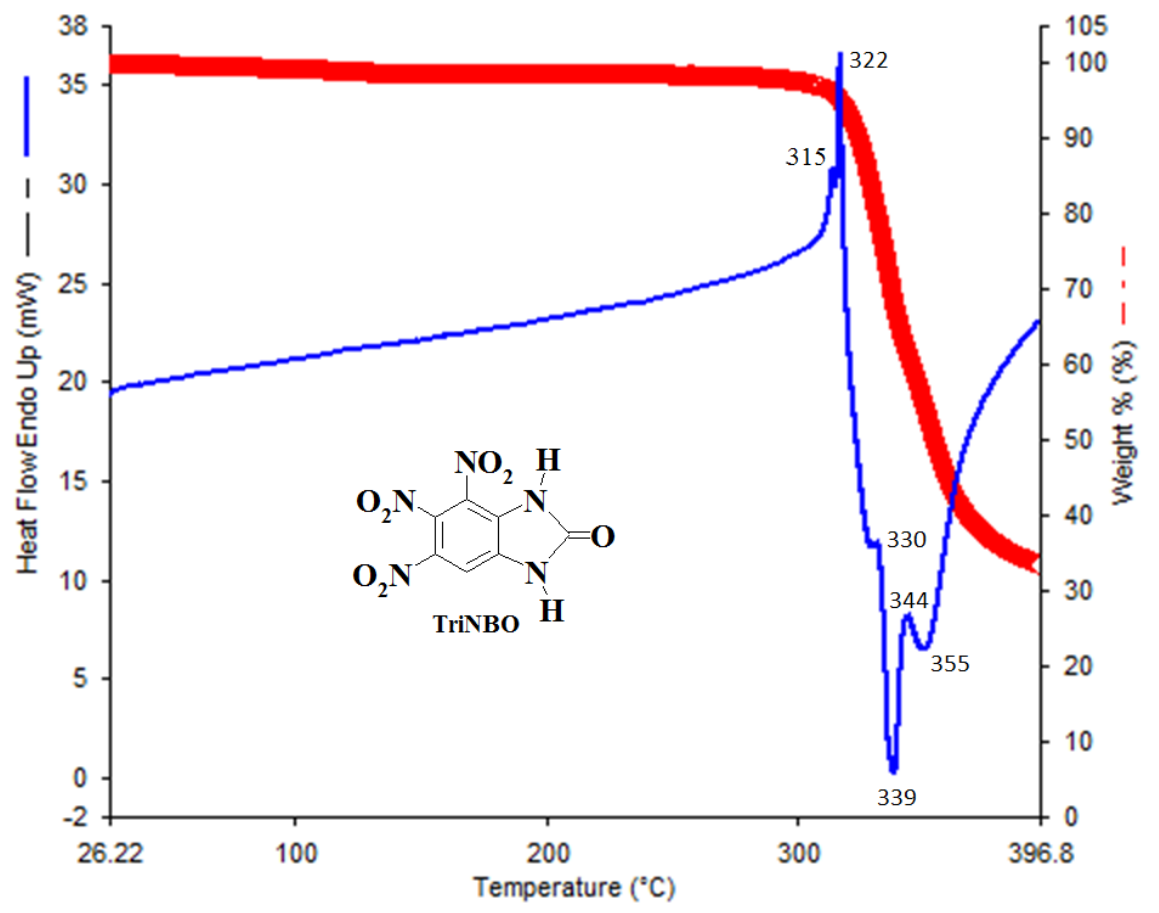
Figure 4. Thermogravimetric analysis of 4,5,6-trinitro-1,3-dihydro- 2H -benzimidazol-2-one (TriNBO) ( 1 ) sample (5 mg) (5 °C/min).